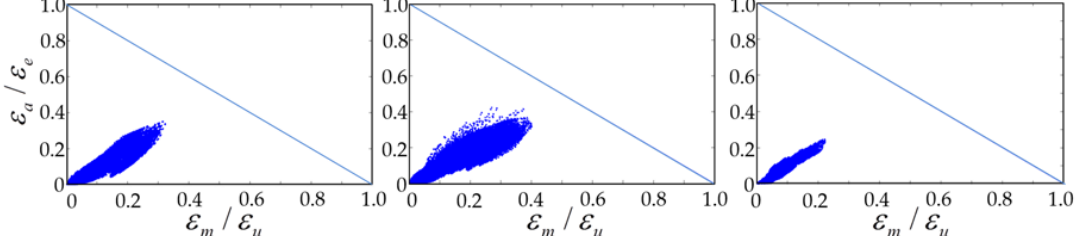
Figure 10. Goodman diagram comparison of conventional DES stent ( left ), conventional depot stent ( middle ), and rhombic ‐ shaped channel stent ( right , reservoir length 100% of the strut length).